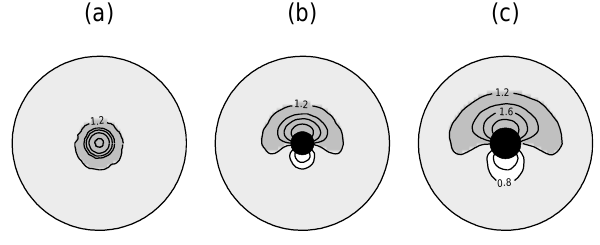
Fig. 5. Cross-sectional views of the calculated relative density field at (a) , (b) , and (c) in Fig. 4.